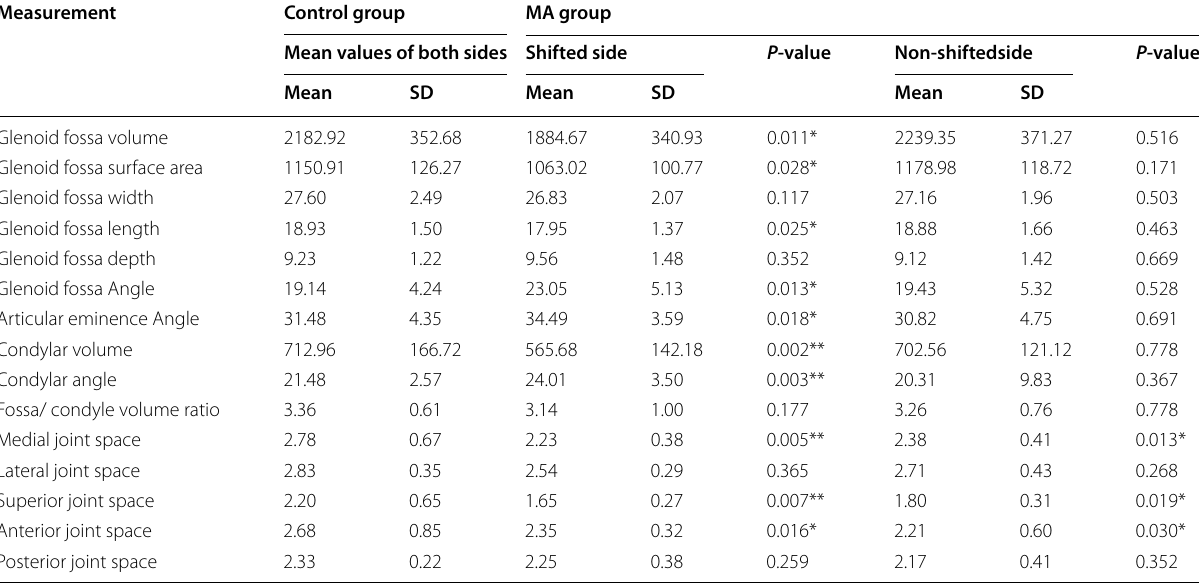
Table 6 Comparison of temporomandibular joint morphology on the shifted and non‑shifted sides of the MA group and mean values of both sides of the control group